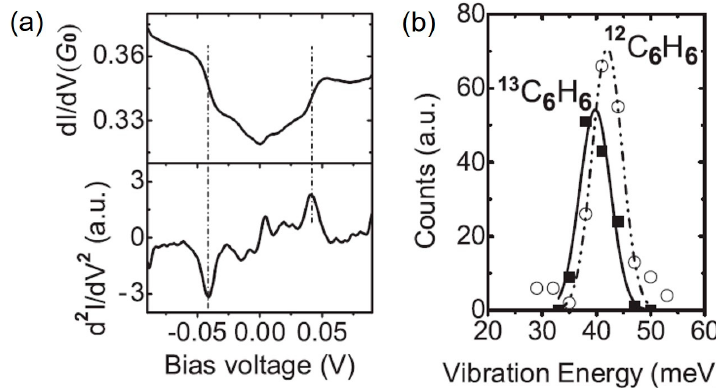
Figure 5. ( a ) Differential conductance curve (upper panel) and its derivative (lower panel) of the benzene single-molecule junction with Pt electrodes, measured at a zero bias conductance of 0 . 3 G 0 ; ( b ) Distribution of vibrational energy for 13 C 6 H 6 and 12 C 6 H 6 /Pt junctions. Reproduced with permission